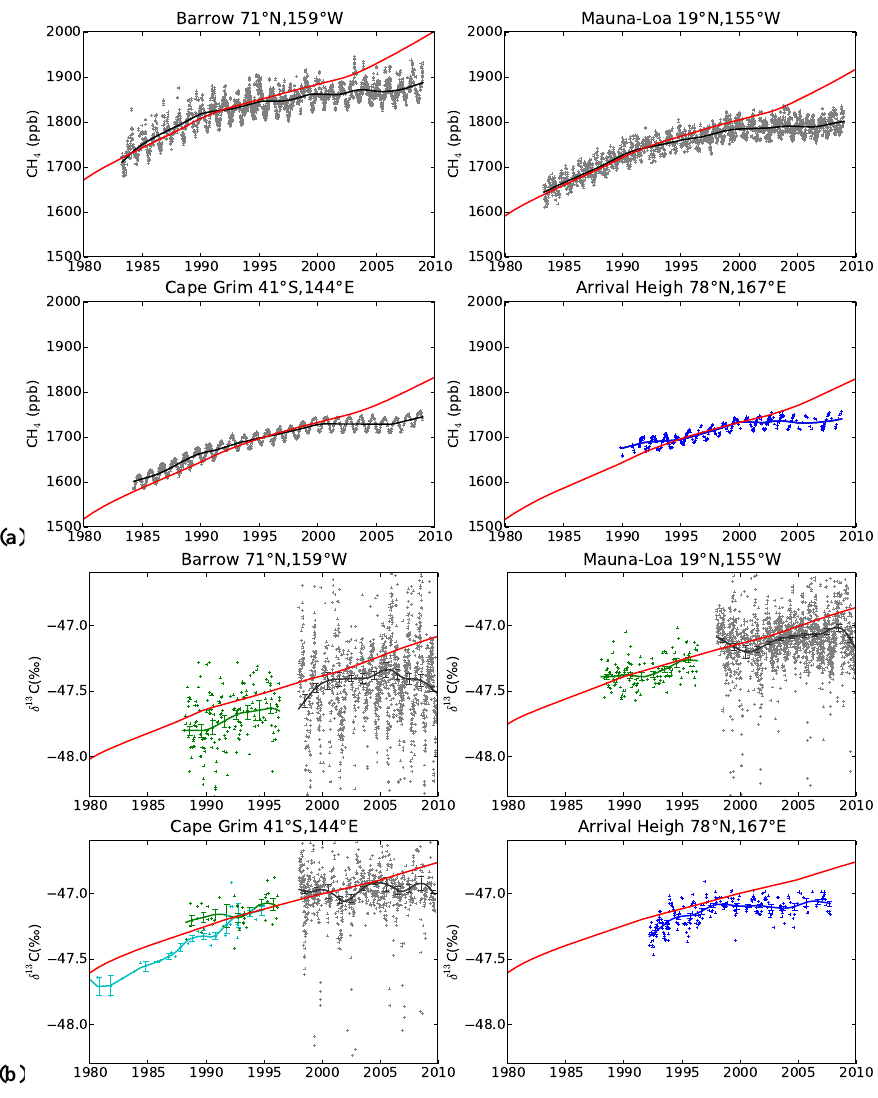
Fig. 2. Comparison between model scenario S0 and measurements for four representative stations, for CH 4 (a) and δ 13 C-CH 4 (b) . Model results, shown as solid red lines, are deseasonalized. Measurements, shown as dots (real measurements) and as solid lines (deseasonalized trends), are from: grey: Dlugokencky et al. (2010) (NOAA); light blue: Francey et al. (1999); green: Quay et al. (1999); blue: Allan et al. (2005) (NIWA). Error bars in the trends lines for isotopes represents the yearly uncertainty of the